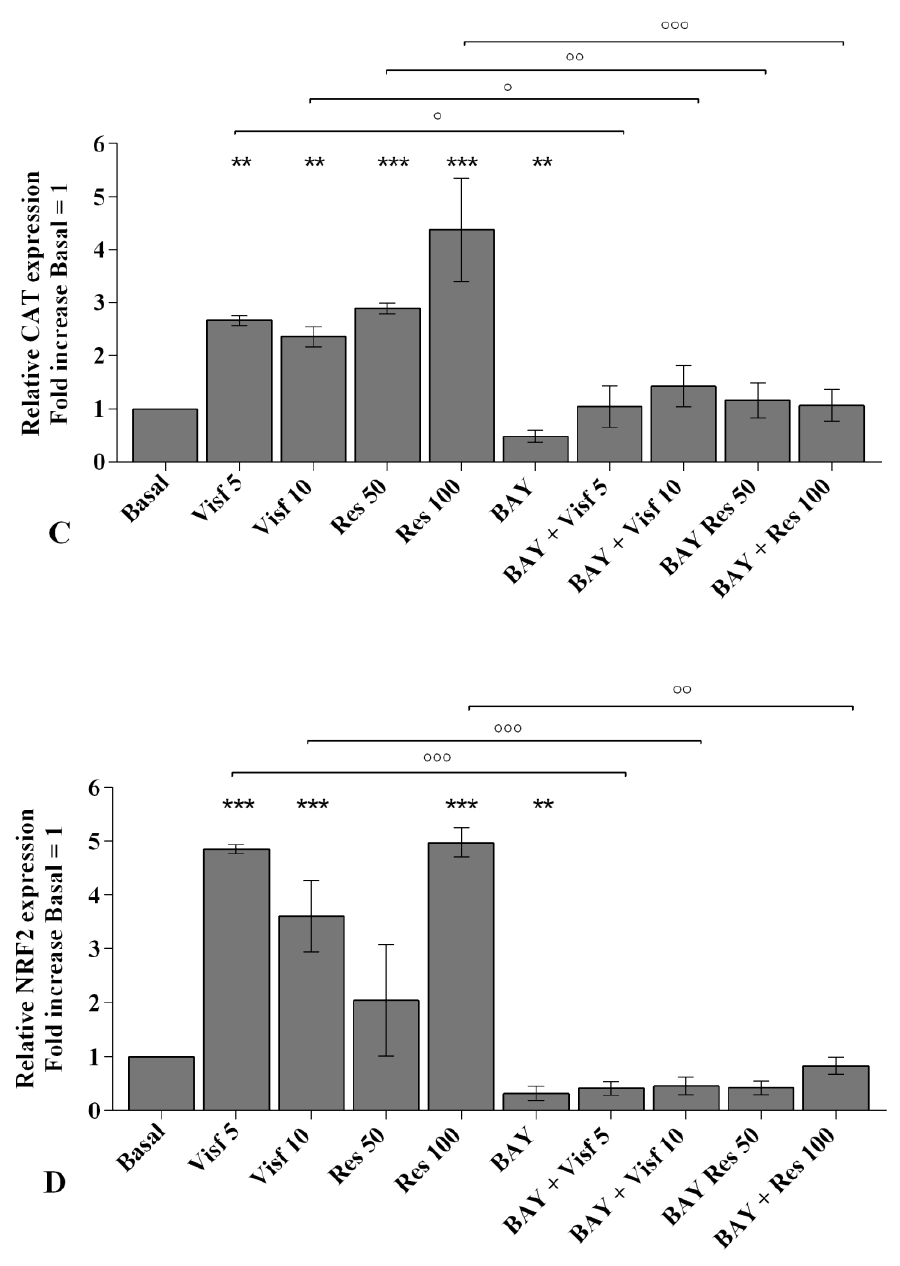
Figure 12. Expression levels of B-cell lymphoma ( BCL ) 2 ( A ), superoxide dismutase ( SOD-2 ) ( B ), catalase ( CAT ) ( C ), nuclear factor erythroid 2 like 2 ( NRF2 ) ( D ) by real-time PCR. Human osteoarthritic (OA) synovial fibroblasts were evaluated at basal condition, after 2 h pre-incubation with a specific nuclear factor (NF)- κ B inhibitor (BAY 11-7082, IKK α / β , 1 µ M) and after 24 h of stimulus with visfatin (5 and 10 µ g / mL) and resistin (50 and 100 ng / mL). The gene expression was referenced to the ratio of the value of interest and the value of basal condition (basal, cells without treatment) reported equal to 1. Data were expressed as mean ± SD of triplicate values. ** p < 0.01, *** p < 0.001 versus basal condition. ◦ p < 0.05, ◦◦ p < 0.01, ◦◦◦ p < 0.001 versus BAY. BAY = BAY 11-7082, Visf = visfatin, Res = resistin.